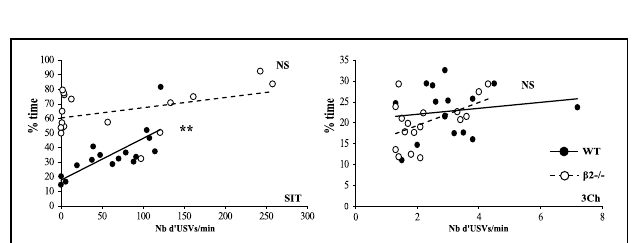
FIGURE 4 | Effect of social feedback. (A) Percentage of time spent in contact to, and in following the conspecific during the social interaction task (SIT). (B) Percentage of time spent in contact with the conspecific in the social interaction task (SIT) and in the 3Ch task (3Ch). (C) Number of ultrasonic vocalizations—USVs—emitted in each condition. Datas are presented for WT and β 2 − / − mice as mean ± SE. ∗∗∗ p < 0 . 0001 for Mann-Whitney paired comparisons.